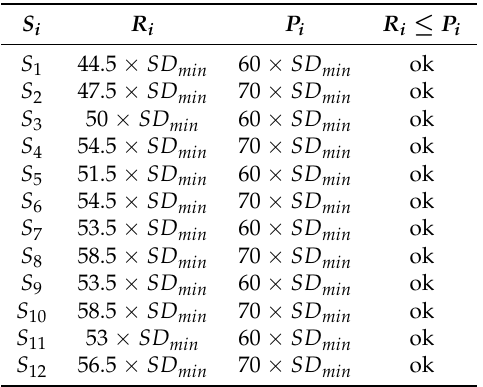
Table 2. Timing Constraints for all Message